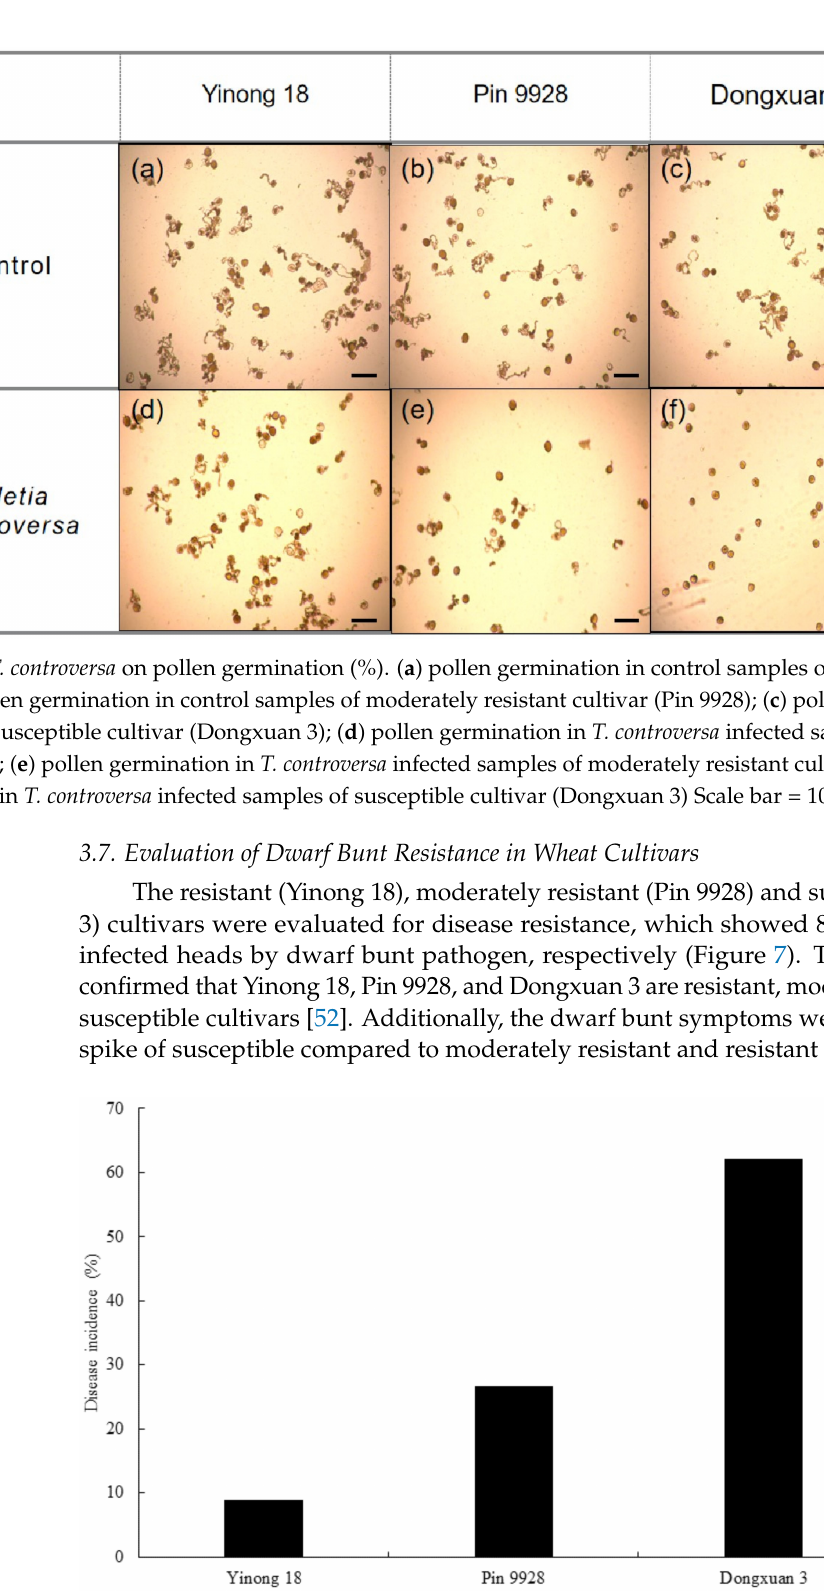
Figure 7. Level of disease incidence in resistant (Yinong 18), moderately resistant (Pin 9928) and susceptible (Dongxuan 3) wheat cultivars to T. controversa infection. Yinong 18 showed 8.89%, Pin 9928 showed 26.67%, and Dongxuan 3 showed 62.2% disease